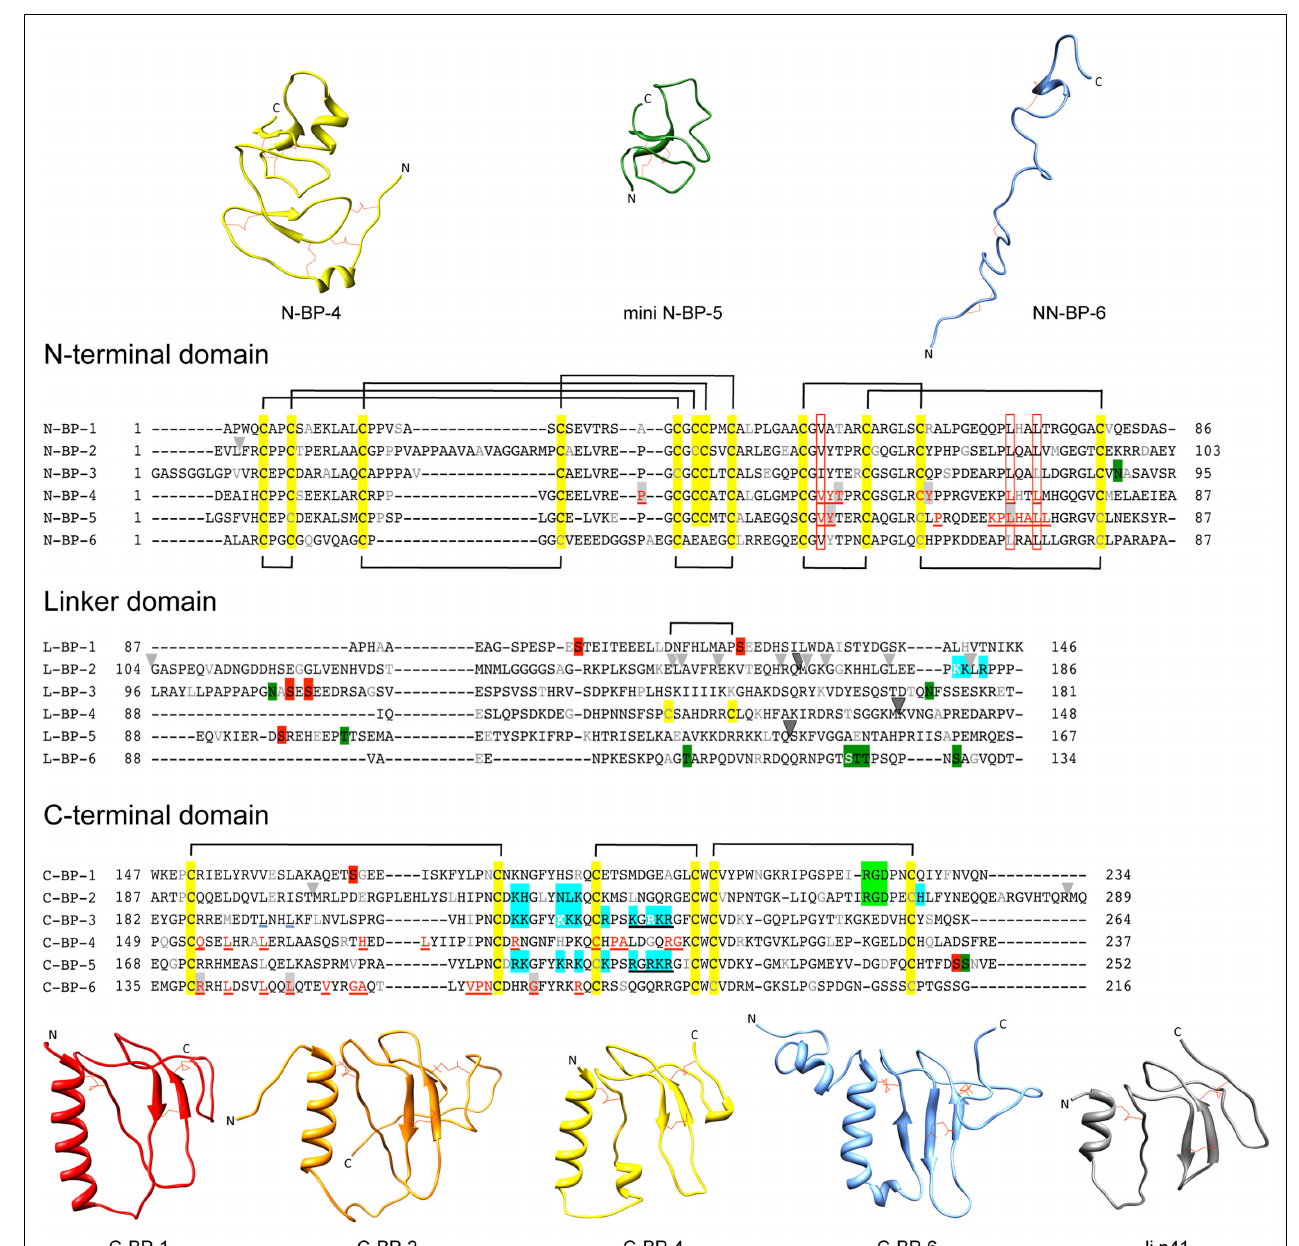
Monget et al., 2003); Blue boxes, IGFBP heparin-binding domains confirmed by site-directed mutagenesis or NMR-IGFBP-2 (Russo et al., 2005; Kuang et al., 2006), IGFBP-3 (Firth et al., 1998), and IGFBP-5 (Arai et al., 1996b); Filled red boxes, phosphorylation sites (Jones et al., 1993a; Coverley et al., 2000; Gibson et al., 2001; Graham et al., 2007; Dolcini et al., 2009); Light green boxes, integrin binding sites (Jones et al., 1993c; Kuang et al., 2006), Dark green boxes; glycosylation sites (Neumann et al., 1998; Firth and Baxter, 1999; Graham et al., 2007); Black underlined text, nuclear localization sequences (Schedlich et al., 1998; Iosef et al., 2008); Blue underlined text, Leu194 and Leu197 of IGFBP-3 involved in nuclear export (Paharkova-Vatchkova and Lee, 2010). Protein sequence SwissProt accession numbers are as follows: IGFBP-1 (P08833), IGFBP-2 (P18065), IGFBP-3 (P17936), IGFBP-4 (P22692), IGFBP-5 (P24593), IGFBP-6 (P24592).